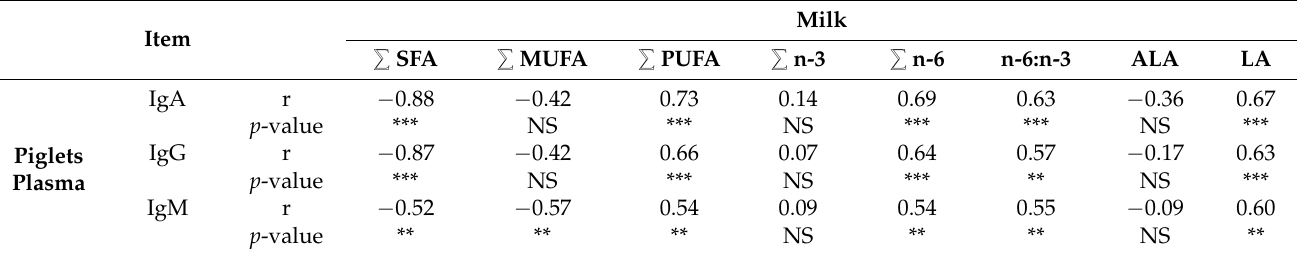
Table 9. Spearman coefficient correlation in piglets.